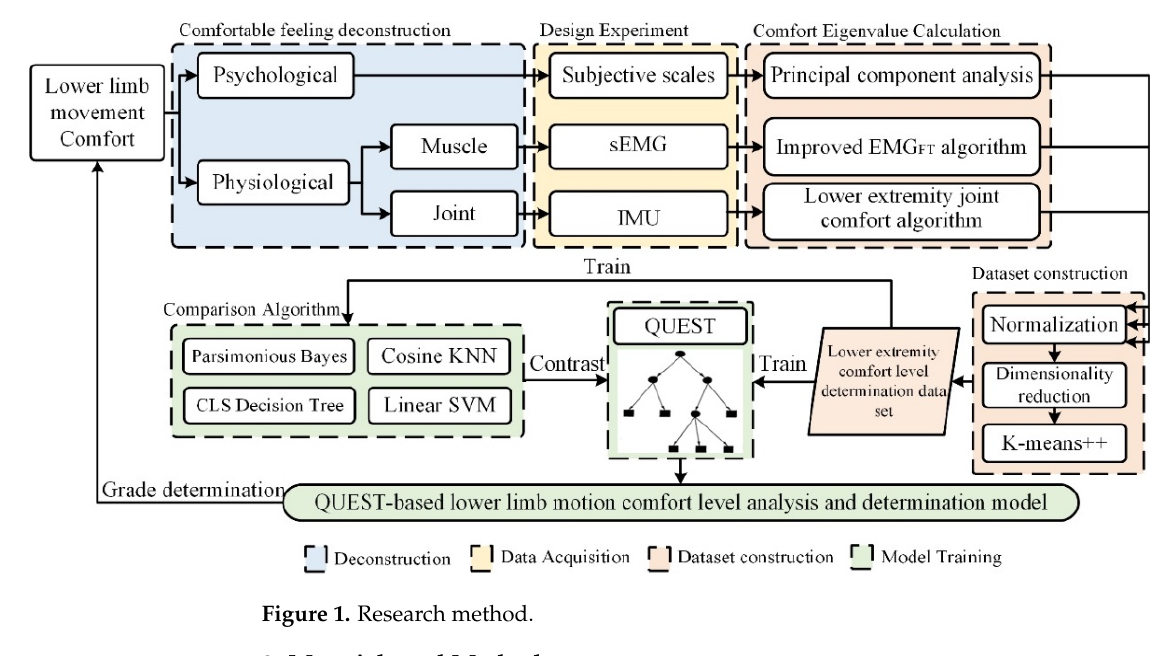
Figure 1. Research method.